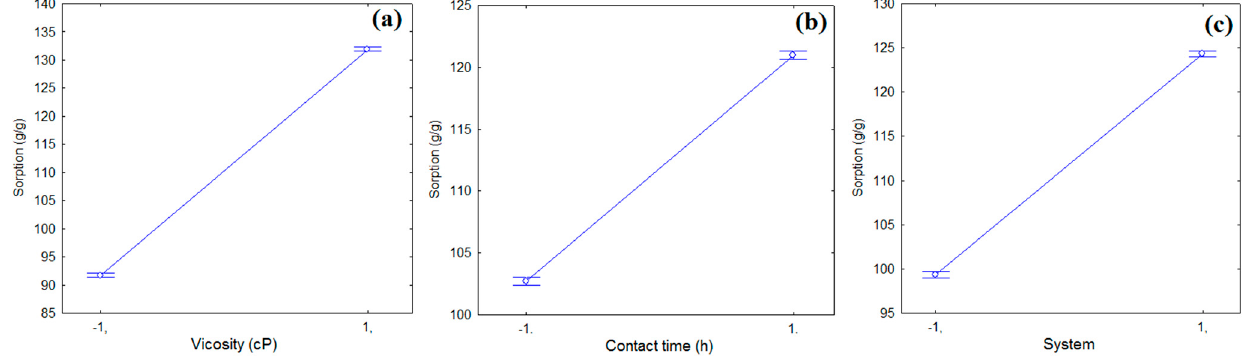
Figure 4. Effects of the independent variables: ( a ) viscosity, ( b ) contact time, and ( c ) sorption system, in relation to the mean values of the oil sorption capacity (95% confidence interval).